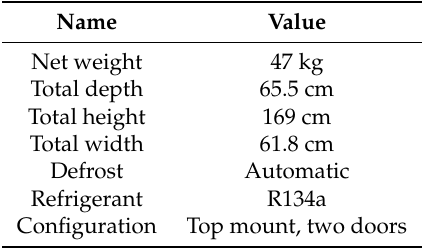
Table 1. General characteristics of the